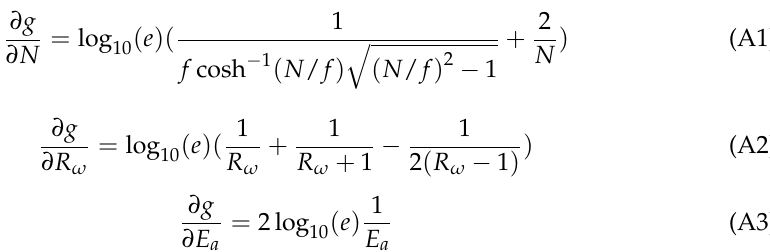
Figure A4. The histogram of buoyancy frequency at 600 m depth. The red line represents the PDF of fitted normal distribution. The distribution of N is found to obey the normal distribution using the Kolmogo- rov – Smirnov test. From Figure A3d, we know that